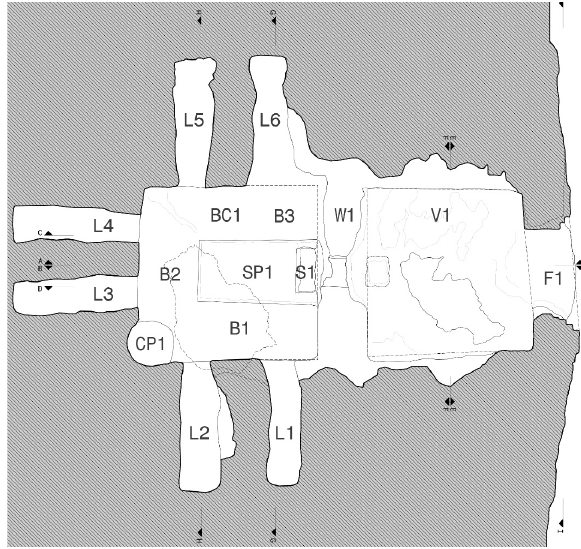
Figure 2. Cave no. 26: plan of the